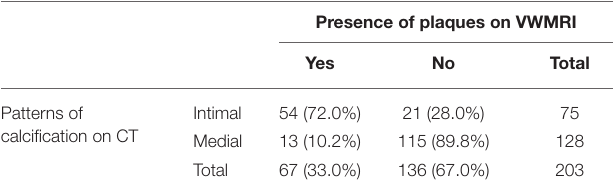
TABLE 3 | Correlation between calcification patterns on CT and the presence of plaques on